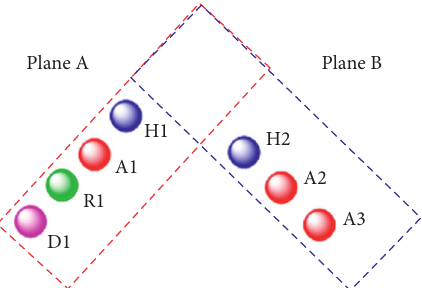
Figure 3: The pharmacophoric model of CBSIs with two planes: plane A (red) consists of points A1, D1, H1 and R1; plane B (blue) consists of points A2, A3, and H2 (based on Ref. [33,